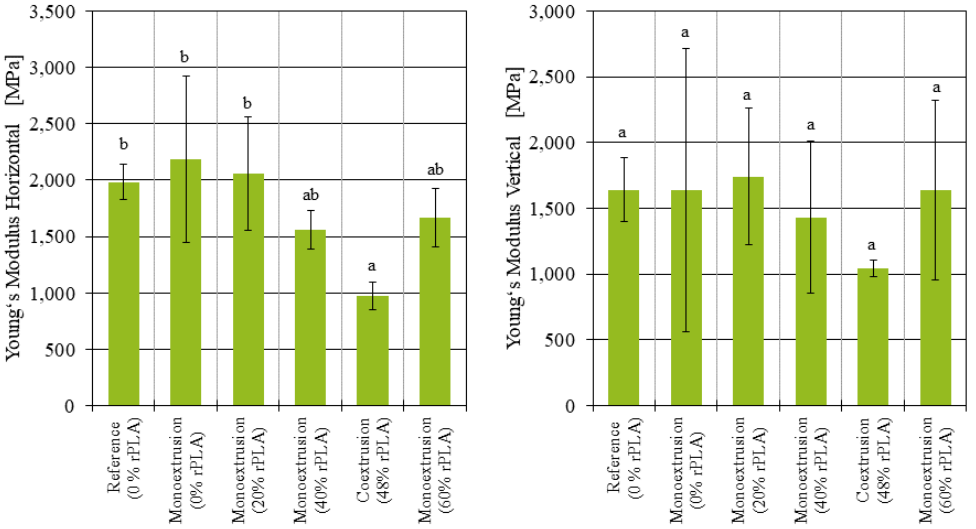
Figure 6. Young’s modulus of additively manufactured samples manufactured in horizontal and vertical